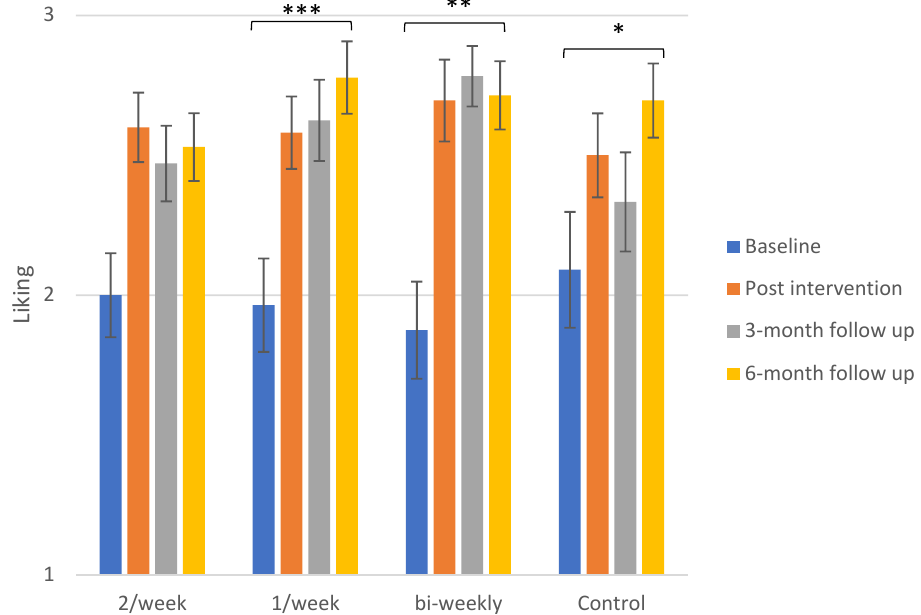
Figure 1. Mean liking scores ± SEM of daikon for the different exposure groups and control groups for the four control visits. The significance of the overall differences only (baseline to 6-month follow-up) for the groups of 1/week and bi-weekly exposure and the control group is depicted. The overall increase in liking of daikon was not found to be significant for the group that received daikon 2/week. The detailed differences and their statistical significance are given in the text. Significance levels: ‘***’: ≤ 0.001, ‘**’: ≤ 0.01, ‘*’: ≤ 0.05.